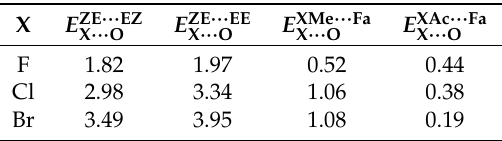
Table 4. Interaction energies (kcal/mol) of the X · · · O intramolecular contact in ZZ-3-halogenopropenal estimated by means of several dimers utilized in Dimer Model (DM)